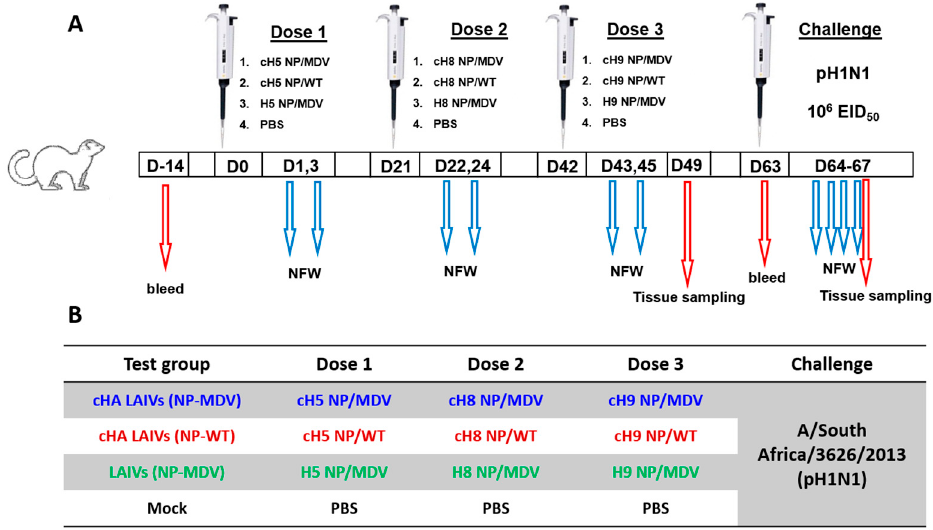
Figure 2. Overview of study design ( A ) and designation of the study groups ( B ).